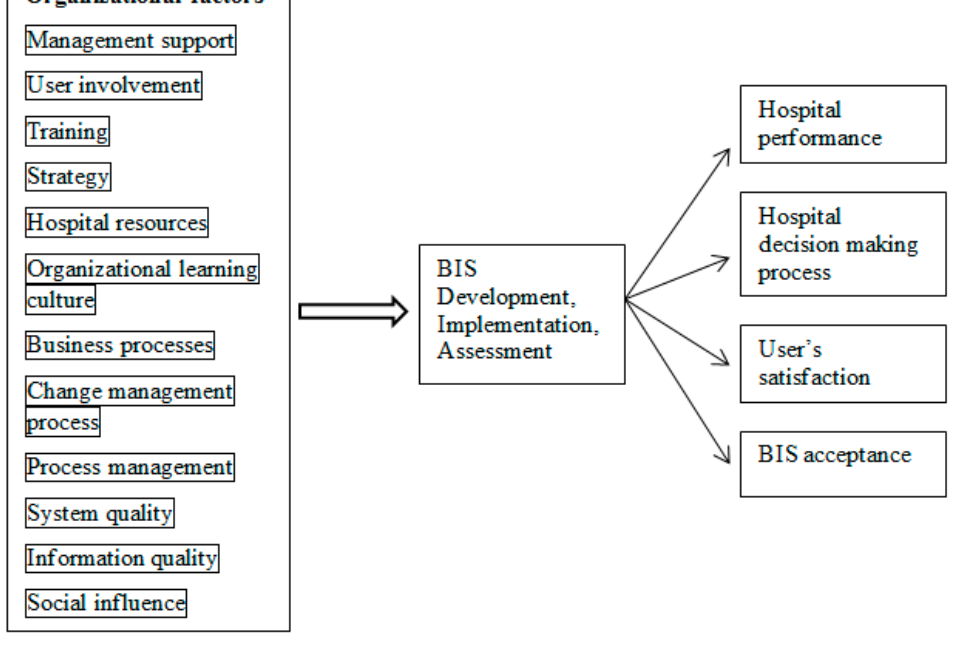
Figure 2. Proposed framework.